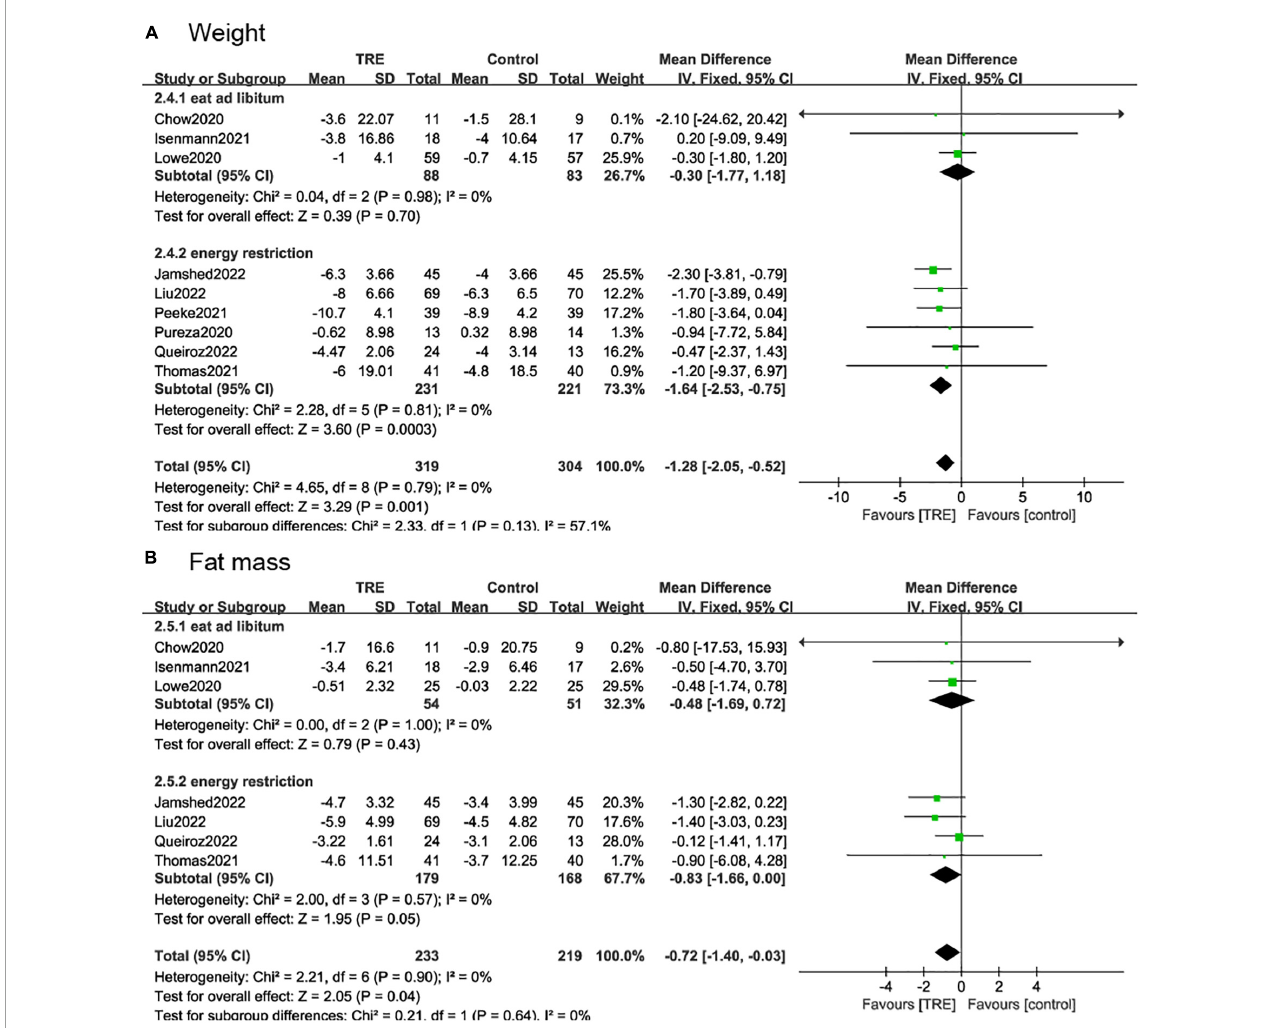
FIGURE8 Forest plot of (A) weight change in subgroups of participants allowed to eat libitum (2.4.1) and participates with caloric restriction (2.4.2); and (B) fat mass change in subgroups of participants allowed to eat libitum (2.5.1) and participates with caloric restriction